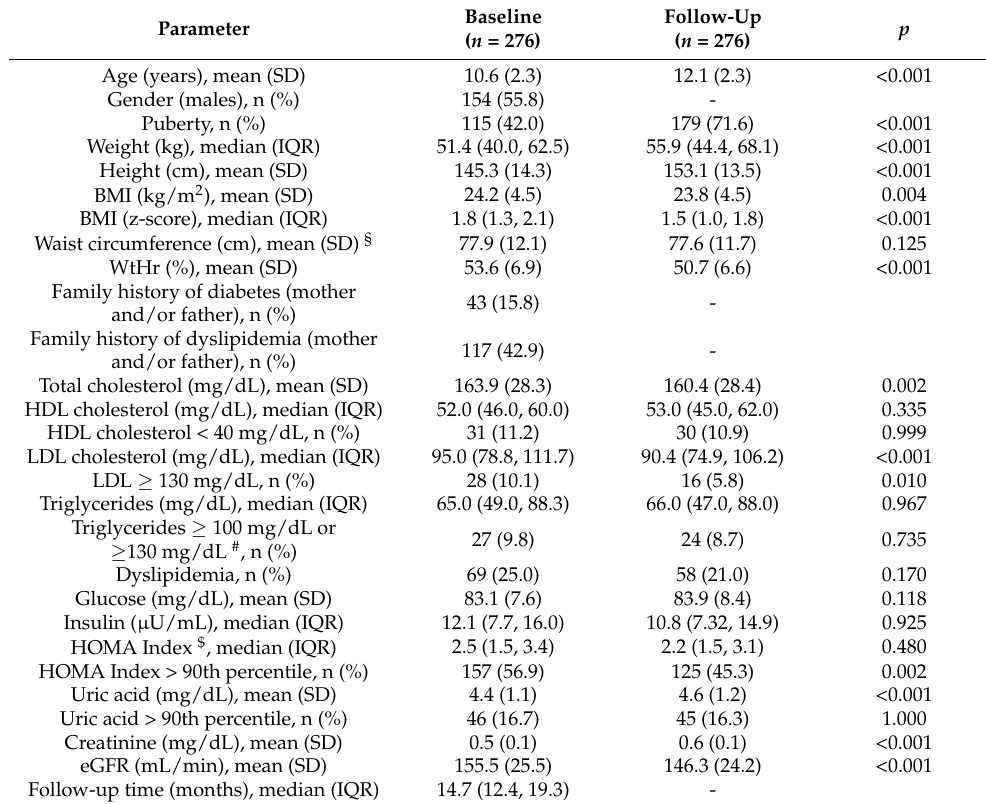
Table 1. Anthropometric and clinical characteristics at baseline and at